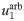
Experiment 2: Concurrent linear and nonlinear tasks.(A) Schematic of the experiment. Input consists of five streams: two cue channels u+ and u−, two streams of bounded, uniformly distributed noise u1arb and u2arb that are filtered by a Gaussian kernel, and the additional trained feedback signal dtf. In addition to the trained feedback signal, the fDCR computes three desired outputs d1, d2, and d3, corresponding to a linear cued task, nonlinear cued task, and nonlinear cue-independent task, respectively. (B) Comparison between desired (blue) and observed (orange) fDCR output signal d1 (top), d2 (middle), and d3 (bottom). (C) Scatter plots of the target verses observed output for both training (yellow) and validation (brown) data sets, when the target is d1 (top), d2 (middle), and d3 (bottom). (D) Correlation coefficient between desired and observed fDCR outputs for both training (brown) and validation (yellow), when the target is d1 (top), d2 (middle), and d3 (bottom).